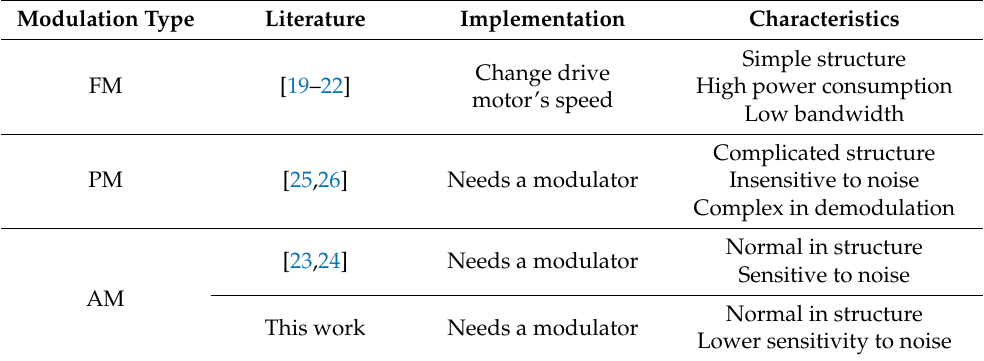
Table 1. Comparison of the antenna in this work with previously published